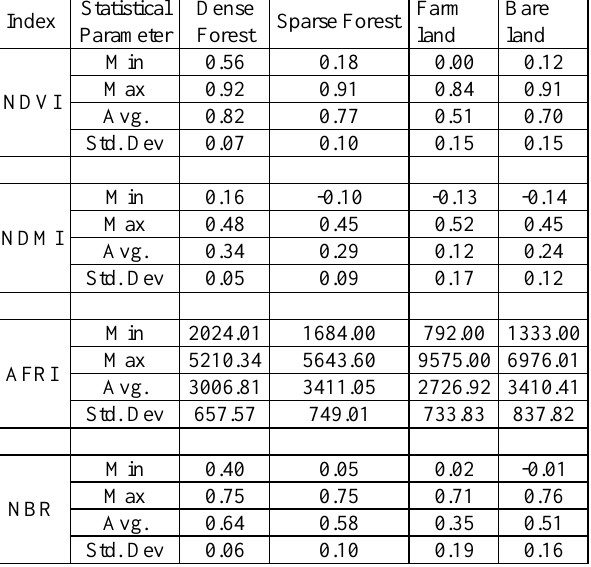
Table1: Statistical estimates for various indices for different land cover types gathered from 2016 to 2021.